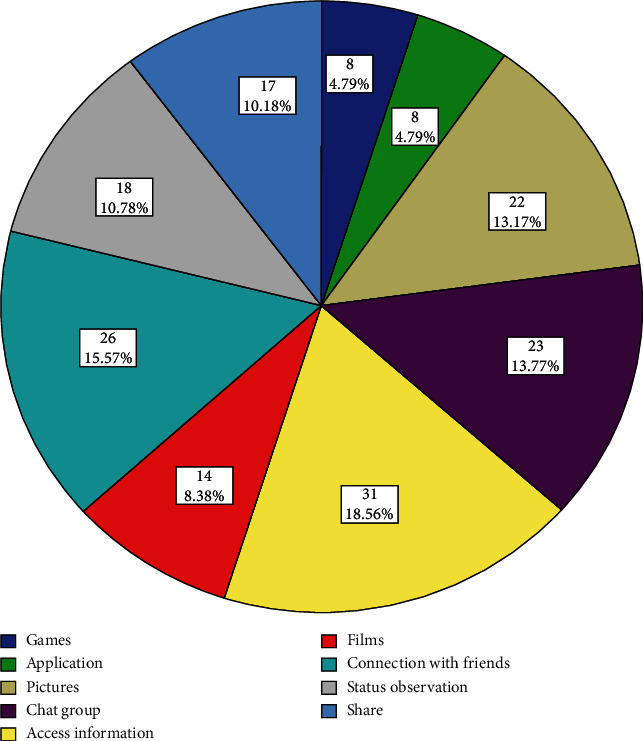
The goal of using social networks.